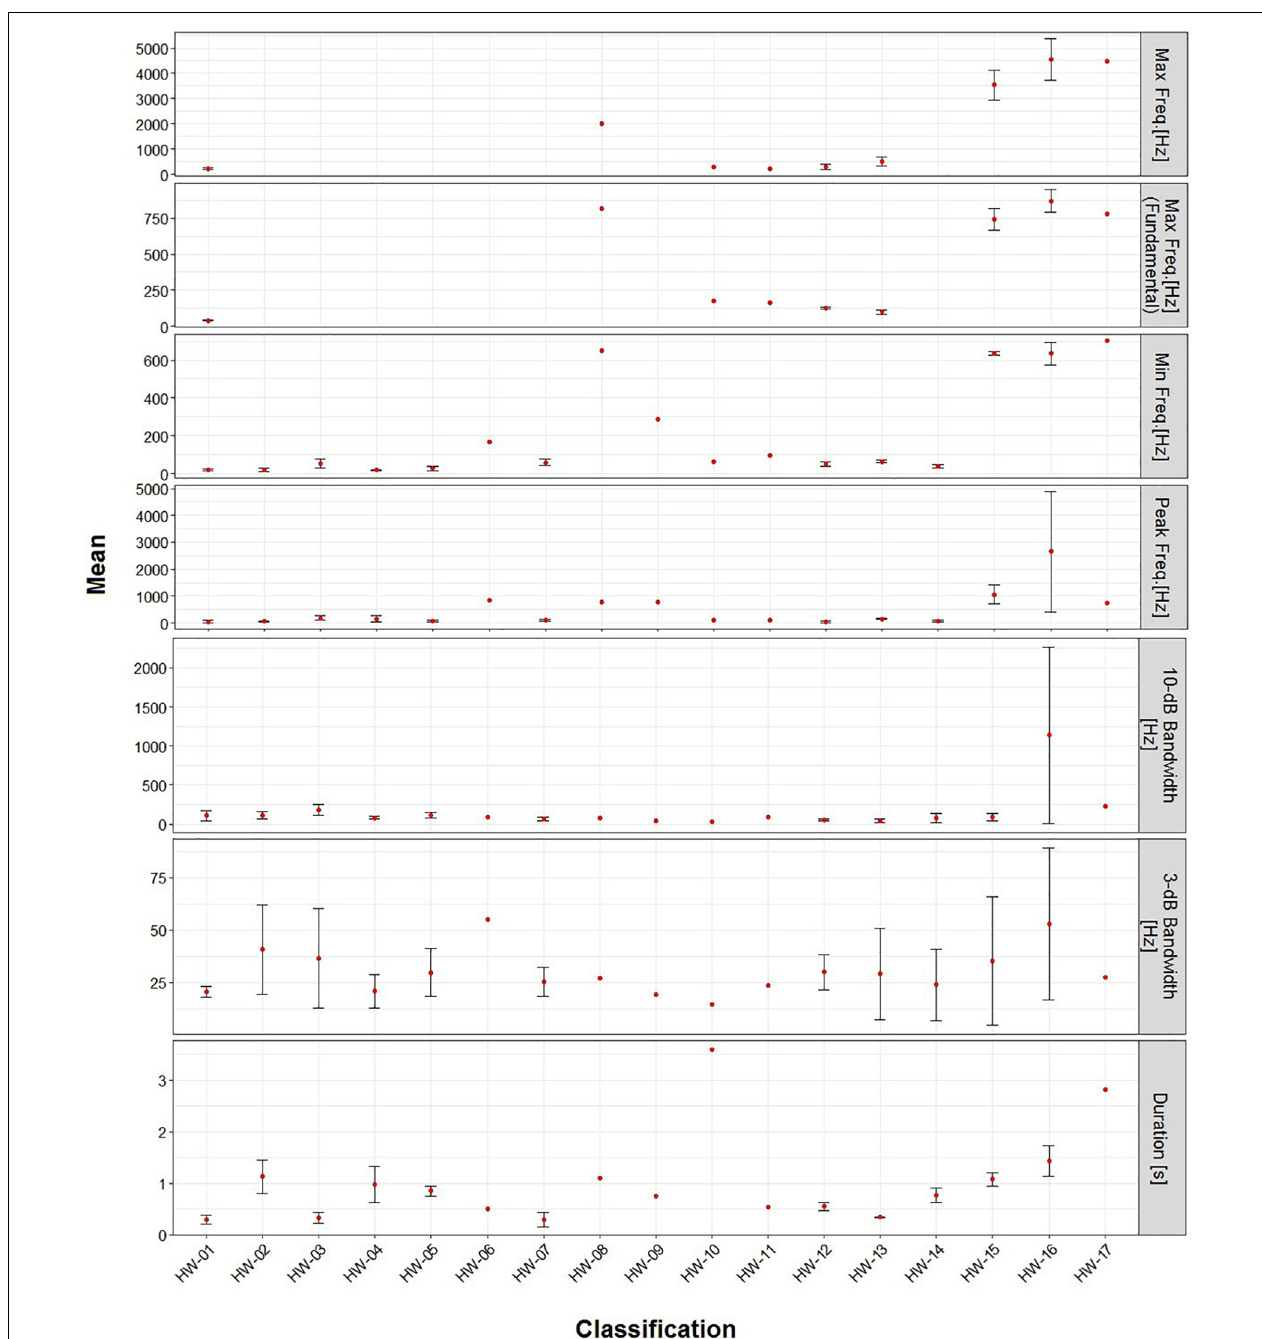
FIGURE 4 | Mean ( ± SD) metrics for the spectrogram parameters of each sound type recorded in November 2011 and 2012 in Geographe Bay and between June and January 2012 off Port Hedland, Western Australia.